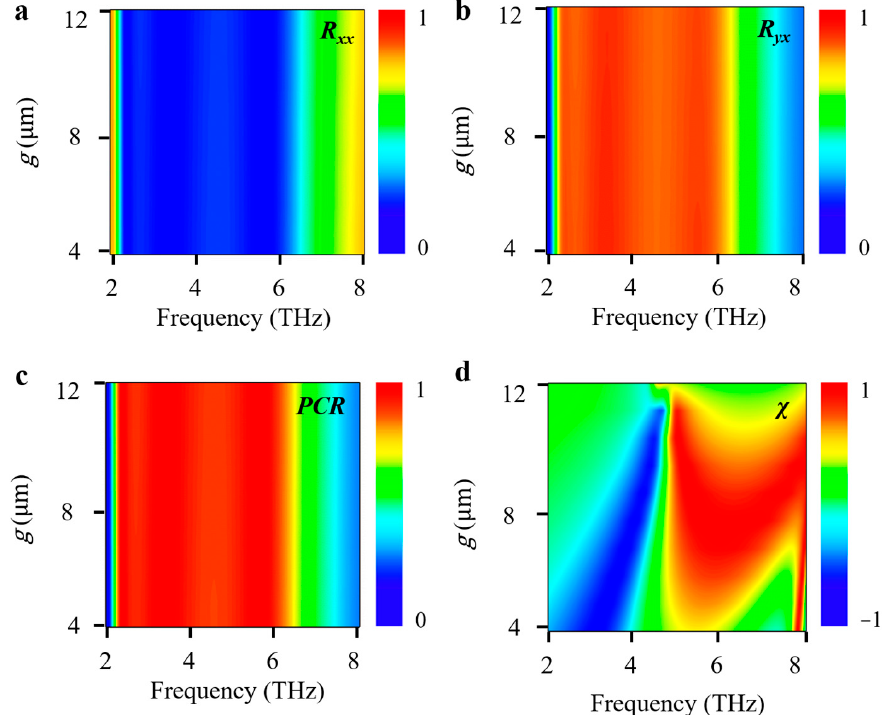
Figure 9. ( a , b ) The spectra of reflection coefficients for forward illuminated x -polarized light for various gap distances g . ( c ) The calculated PCR ( x ) spectra, and ( d ) ellipticity spectra of x -polarized light for various gap distances g . VO 2 is in the metallic state.